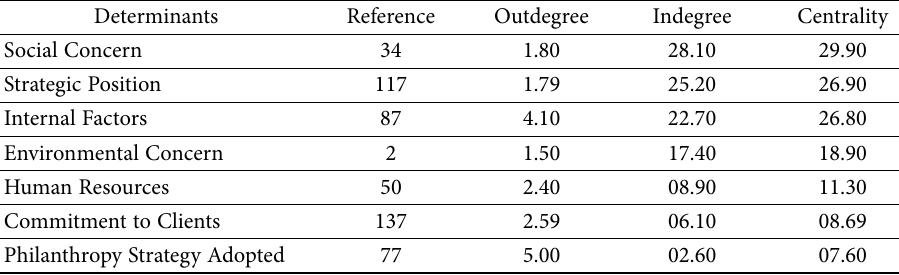
Table 2. Major determinants of sustainable banking [based on centrality] Determinants Reference Outdegree